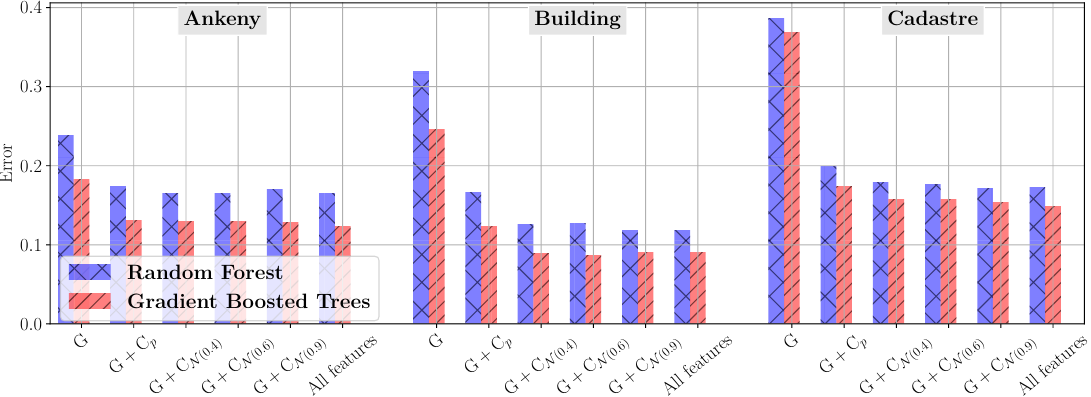
Figure 1. Intra-dataset results: classification error (number of misclassified points divided by overall number of points, the lower the better) when training and testing on different parts of the same dataset. Each dataset is split into physically disjoint training and testing sets through a vertical plane. Incorporating color features C N (0 . 6) yields a significant improvement. The best results are obtained when combining both geometric and color features. For a detailed discussion see section 4.4.